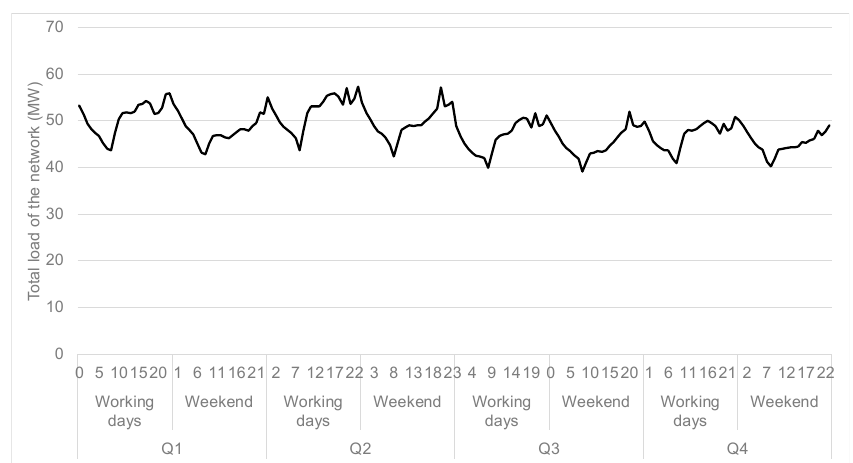
Figure 4. Case study: total load profiles in the different representative days.